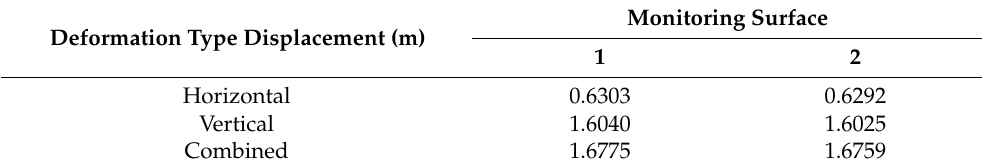
Table 1. Comparison of the maximum deformation of the soil in the filling area of the monitoring